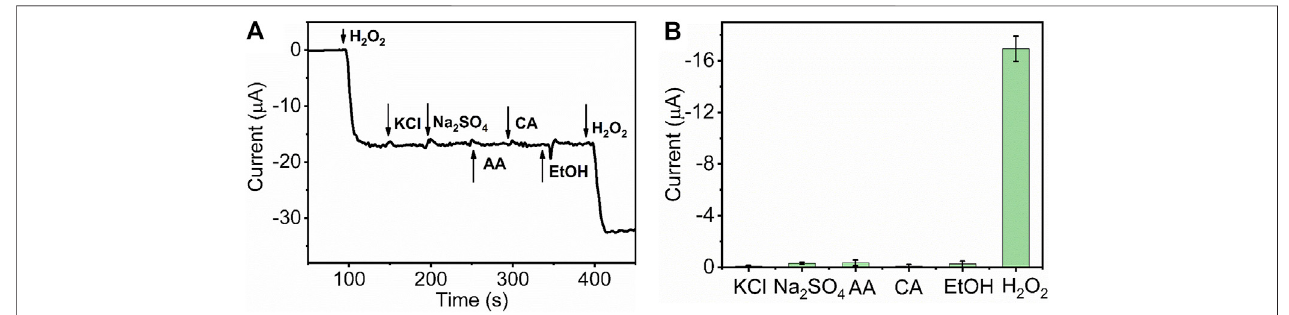
FIGURE 6| (A) I-t curve ofHKUST-1/GCE with the successive injection of1 mM H 2 O 2 , 10 mM KCl, 10 mM Na 2 SO 4 , 10 mM CA, 10 mM AA, C 2 H 5 OH, and 1 mM H